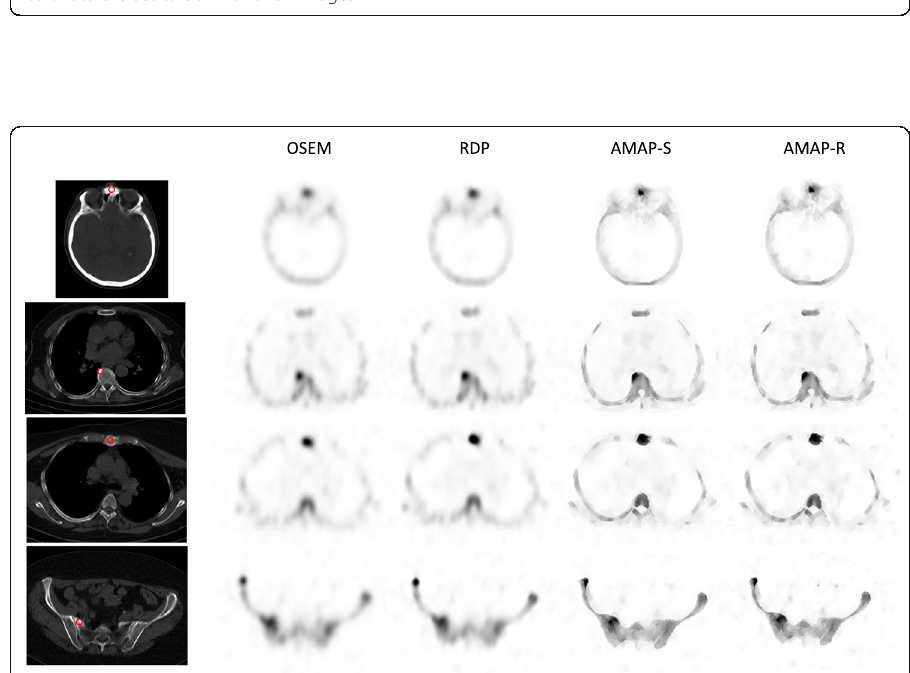
Fig. 7 Example transversal slices of four lesions from clinical patient studies. The red circle presents the VOI used to analyze the studies. The color scale is set to SUV 15 for all images